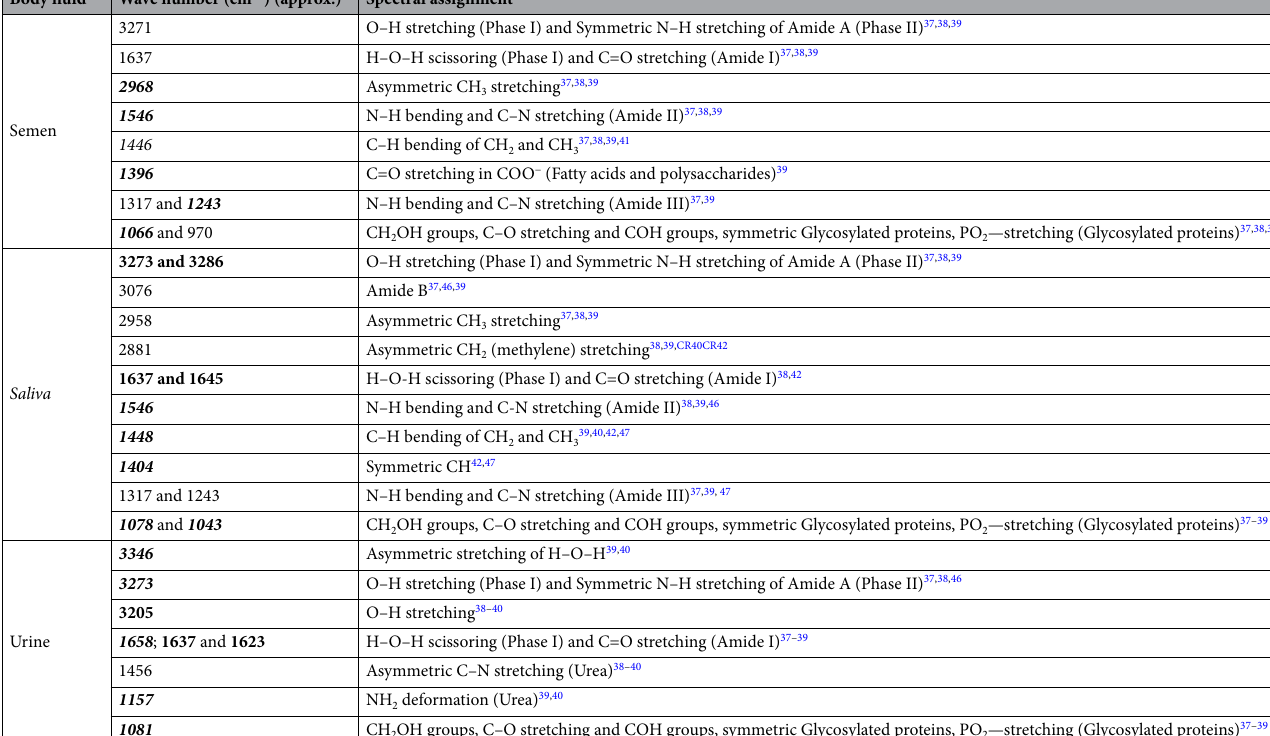
Table 1. Strong, medium and weak peaks observed in all the three body fluids during their ATR-FTIR spectral analysis with their vibrational modes and spectral assignments. ‘Bold’ marks denote the peaks changed during the transition from phase I to phase II and ‘Bold’ + ‘Italic’ mark denotes the age-linked